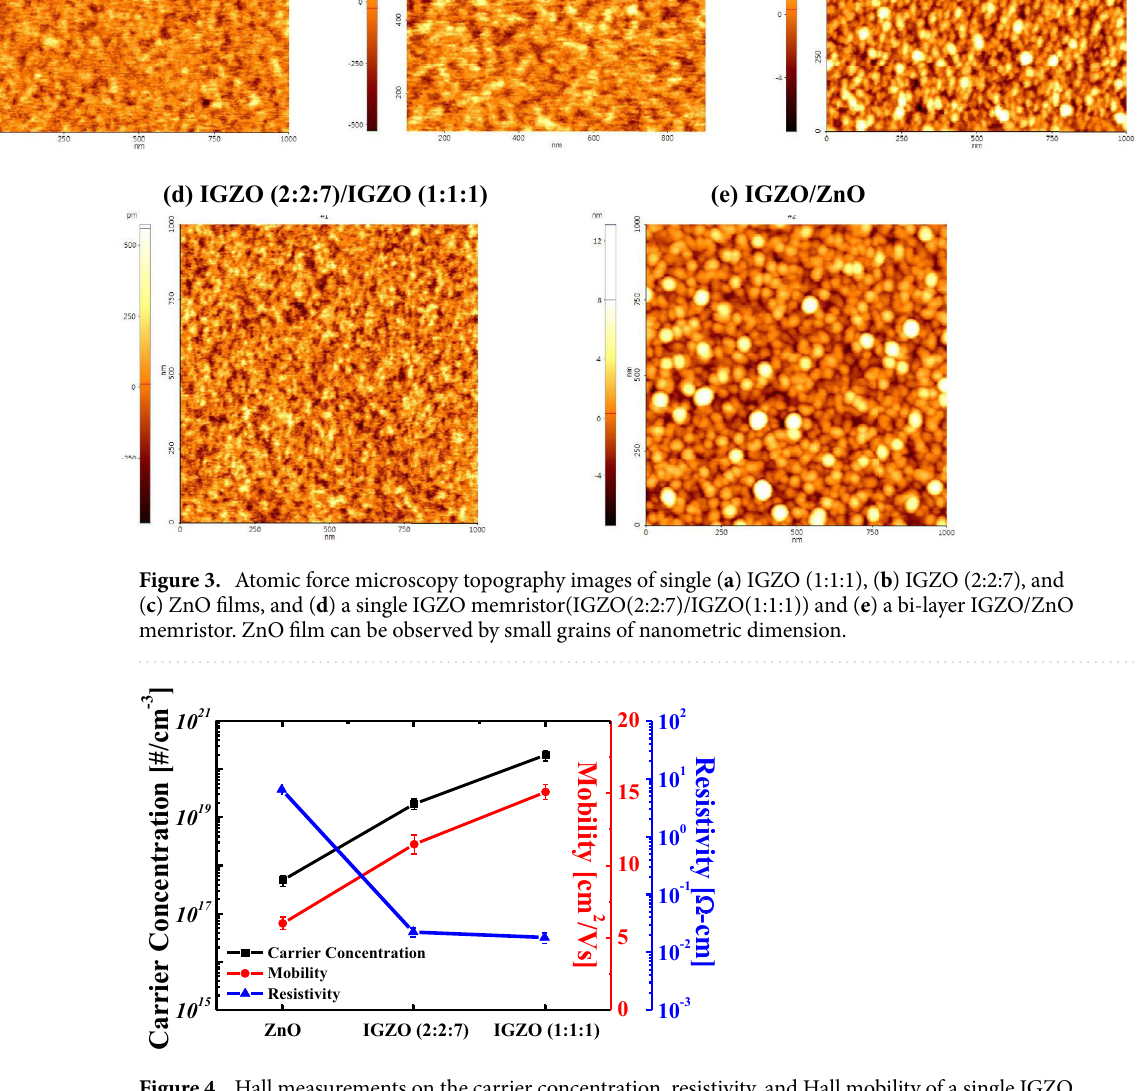
Figure 4. Hall measurements on the carrier concentration, resistivity, and Hall mobility of a single IGZO (1:1:1), IGZO (2:2:7), and ZnO